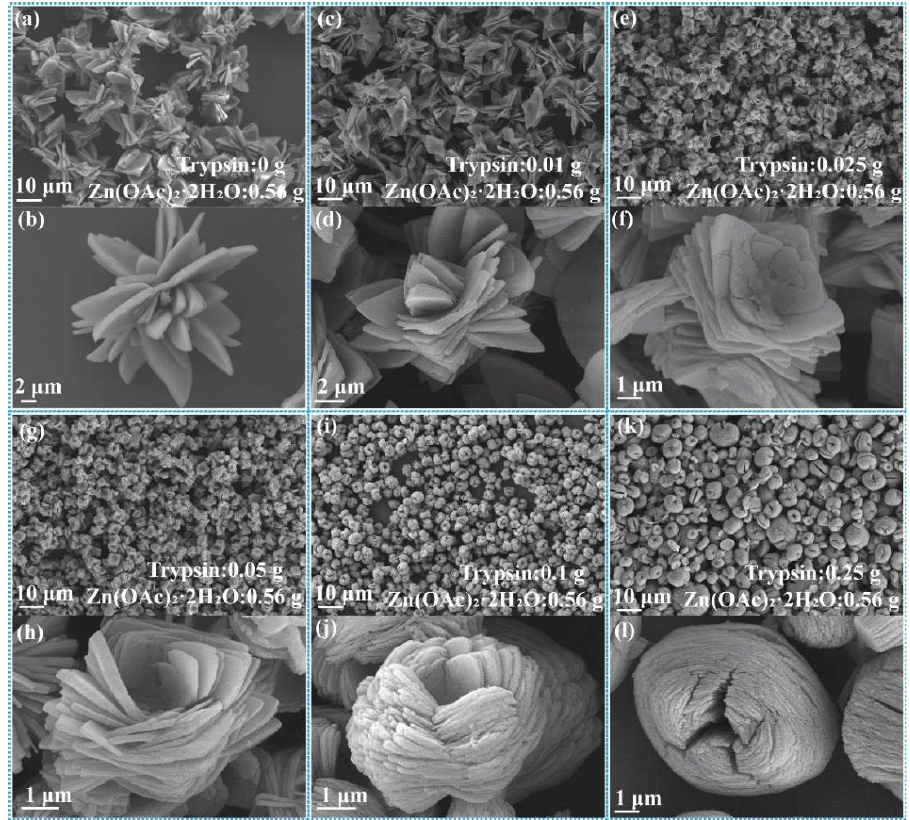
Figure 1. SEM images of trypsin/Zn 3 (PO 4 ) 2 hybrid nanoflowers prepared by adding the following amounts of trypsin: ( a , b ) 0 g, ( c , d ) 0.01 g, ( e , f ) 0.025 g, ( g , h ) 0.05 g, ( i , j ) 0.1 g and ( k , l ) 0.25 g. Zn(OAc) 2 ·2H 2 O was 0.56 g.